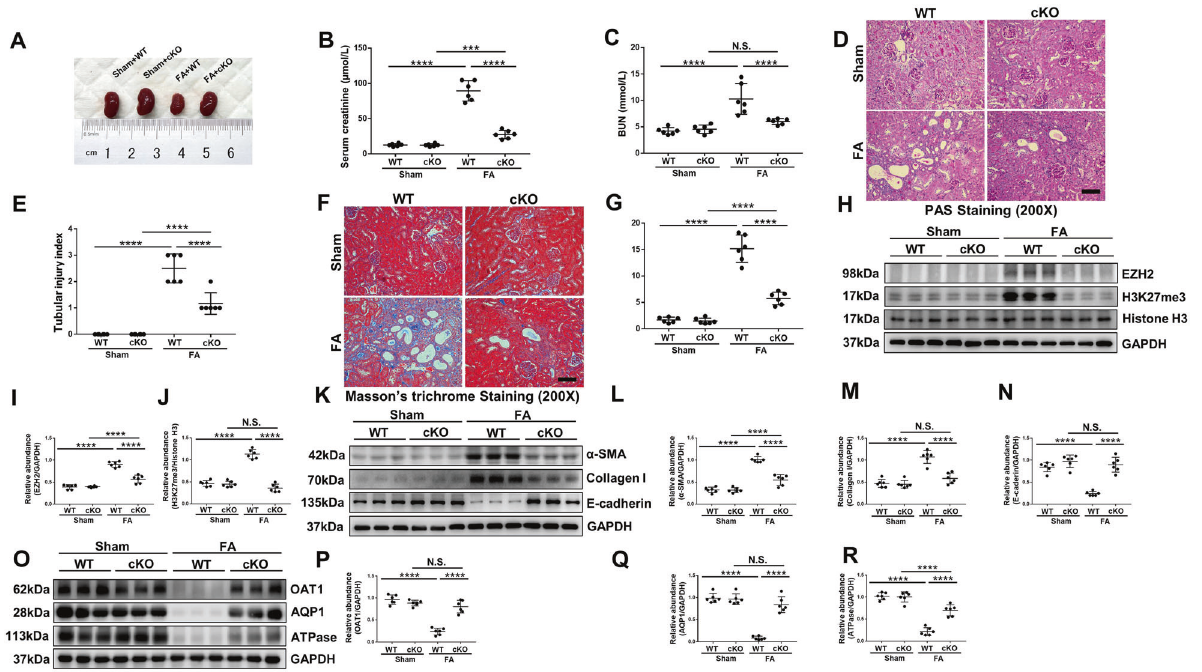
Fig. 3 EZH2 conditional knockout protects against renal dysfunction, suppresses renal fi brosis and loss of TEC transporters in FA induced AKI-to-CKD transition mouse model. The mice in FA model were injected with a single dose of folic acid (250 mg/kg, dissolved in 300 mM NaHCO 3 , i.p.), while the control group was injected with an identical voluminal vehicle (300 mM NaHCO 3 , i.p.) for 4 weeks. A Photograph showed the size, color, and texture of kidney in each group. B Serum creatinine of the mice in different groups. C Blood urea nitrogen (BUN) of the mice in different groups. D Photomicrographs showed the PAS staining of the kidneys. E Morphologic change of tubular injury was scored on the basis of PAS staining described in the Method section. F Photomicrographs showed the Masson ’ s trichrome staining of the kidneys. G The graph showed the positive areas (blue) of Masson ’ s trichrome staining. H Kidney tissue lysates from FA mice were subjected to immunoblotting analysis with speci fi c antibodies against EZH2, H3K27me3, Histone H3 and GAPDH. I , J Expression levels of EZH2 and H3K27me3 in different groups were quanti fi ed by densitometry and normalized with GAPDH and Histone H3 respectively. K Kidney tissue lysates from FA mice were subjected to immunoblotting analysis with speci fi c antibodies against α -SMA, Collagen I, E-cadherin, and GAPDH. L – N Expression levels of α -SMA, Collagen I, E-cadherin in different groups were quanti fi ed by densitometry and normalized with GAPDH. ( O ) Kidney tissue lysates from FA mice were subjected to immunoblotting analysis with speci fi c antibodies against OAT1, AQP1, ATPase and GAPDH. P – R Expression levels of OAT1, AQP1, and ATPase in different groups were quanti fi ed by densitometry and normalized with GAPDH. Data were expressed as means ± SEM. * P < 0.05; ** P < 0.01; *** P < 0.001; **** P < 0.0001. N.S., statistically not signi fi cant, with the comparisons labeled. All scale bars = 50 μ